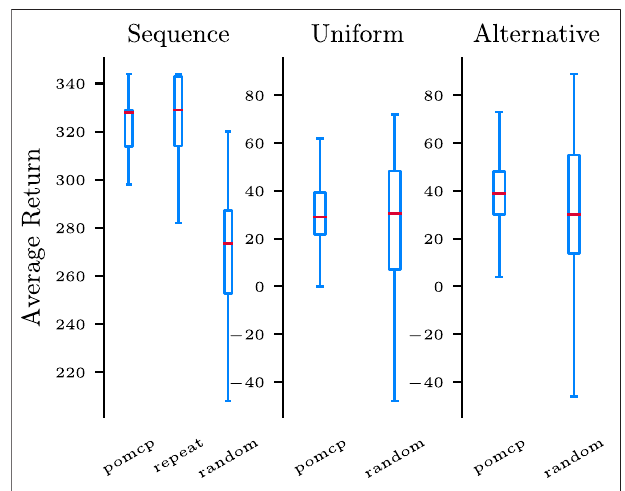
FIGURE 6 | The POMCP policy matches or outperforms ad-hoc strategies against three different HTMs ( sequential , uniform , and alternative task). The results are the distribution of returns over 100 evaluation episodes from the two hand-coded policies ( repeat and random ) as well as the POMCP policy derived from the POMDP. On the last two tasks, the repeat policy fails in most of the cases and is stopped by an upper bound on the horizon of the episode. It gets a very low average return (between − 300 and − 400) that has been omitted from the fi gure to better compare the other